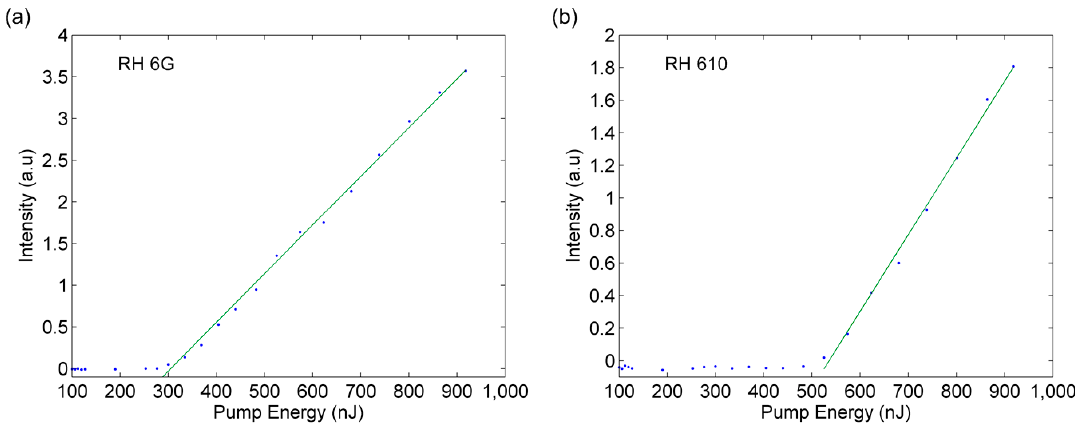
Figure 4. The input–output curve of DFB film dye lasers doped with ( a ) RH 6 G and ( b ) RH 610, showing the lasing threshold energy.